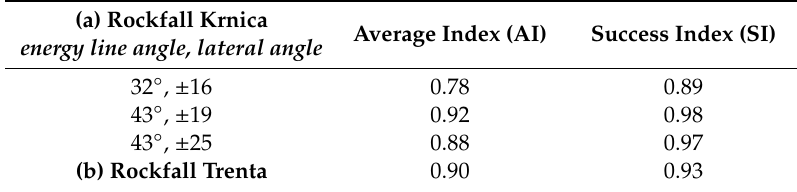
Figure 11. ( a ) Orthophoto image of the Krnica rockfall and ( b ) results of rockfall modelling with the CONEFALL model using different energy line angles and lateral angles. Table 1. Evaluation of the models performances with goodness-of-fit (GOF) indices for (a) the rockfall in Krnica by using the CONEFALL model, and (b) the rockfall in Trenta by using Rockyfor3D model. Both indices have values ranging from 0 to 1 with the optimal value being